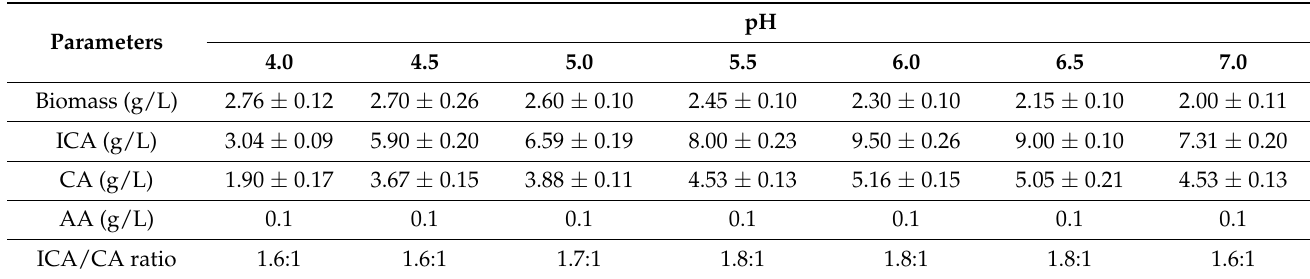
Table 5. Effect of pH medium on the growth of Y. lipolytica VKM Y-2373 and ICA production.